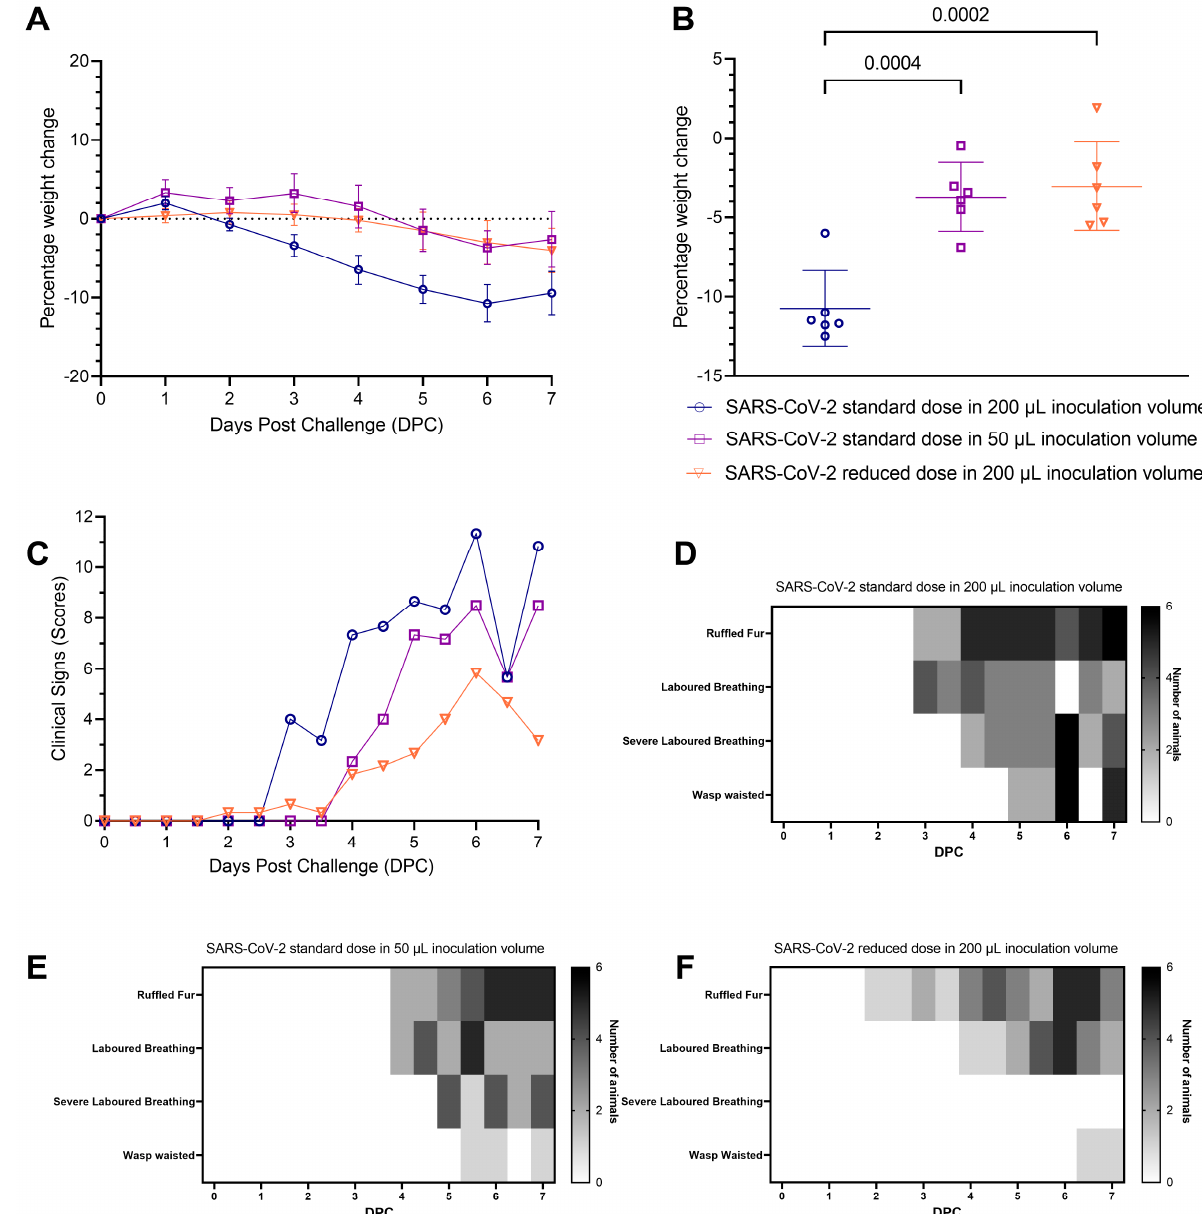
Figure 1. Clinical observations of pathogenicity in hamsters challenged with SARS-CoV-2 delivered in varied inoculum volumes and viral titres. Standard dose of SARS-CoV-2 is 5 × 10 4 Plaque forming units (PFU)/mL, Reduced dose is 1 × 10 2 PFU/mL. ( A ) Percentage weight change from weight at day of challenge measured daily. Lines indicate geomeans and bars indicate 95% confidence interval. ( B ) Weight change at 6 Days Post Challenge (DPC) as a percentage of the initial weight at the day of challenge. Lines indicate means and bars indicate 95% confidence interval. Statistical analysis by one-way ANOVA with Tukey’s multiple comparison correction ( p < 0.05 displayed). ( C ) Clinical scores of the hamsters measured daily, each point is median of six animals, there was high variability and as such error bars are not displayed to improve clarity. Scores were assigned using the following scoring system: Ruffled Fur = 2, Wasp waisted = 3, Laboured breathing = 5, Severe Laboured Breathing = 7. ( D ) Number of hamsters displaying each clinical sign per day in hamsters inoculated with the standard dose in 200 µL. ( E ) Number of hamsters displaying each clinical sign per day in hamsters inoculated with the standard dose in 50 µL. ( F ) Number of hamsters displaying each clinical sign per day in hamsters inoculated with the reduced dose in 200 µL.